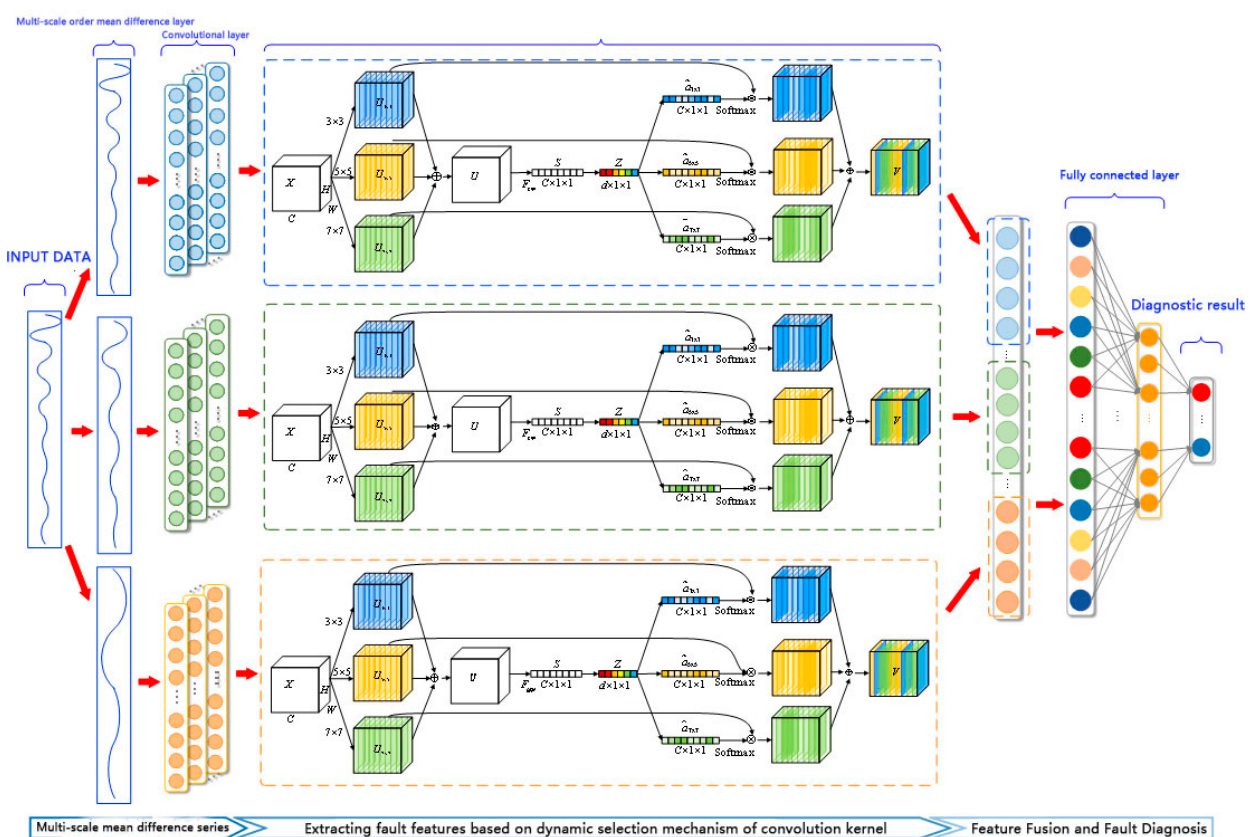
Figure 2. Schematic diagram of the MSCNN-SK